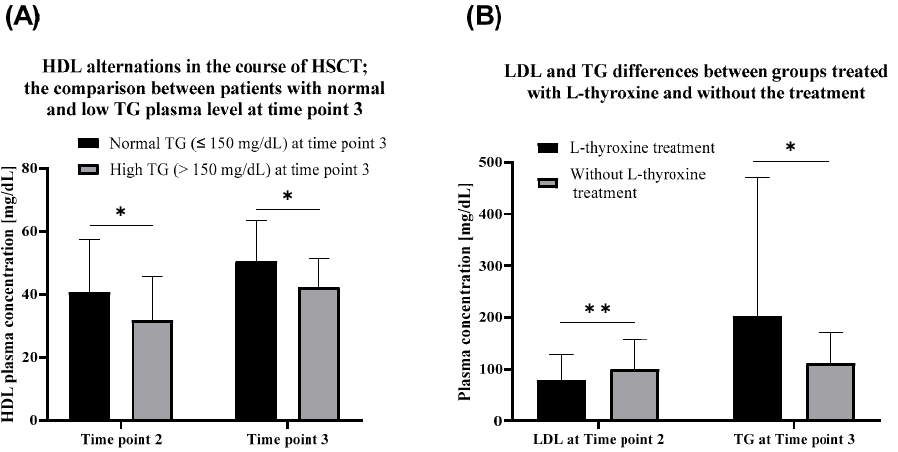
Figure 3. ( A ) HDL alternations in the course of HSCT; the comparison between patients with normal and low triglycerides plasma level (TG) at time point 3. ( B ) LDL (low-density lipoproteins) and triglycerides differences between groups treated with L-thyroxine and the without treatment. *, p < 0.01, (U-Mann-Whitney test). **, p < 0.05, (U-Mann-Whitney test). TG levels among patients with high and normal LDL before HSCT (at time point 1) did not differ after HSCT ( p = 0.904, time point 2) and in the recurring time ( p = 0.932, time point 3). LDL at time point 2 correlated (R = 0.52) with its current level and current cholesterol level (R = 0.17). Total serum cholesterol has not changed during the therapy ( p > 0.05). No correlation between BMI SDS and lipid levels was observed. 3.2. Thyroid Hormones and Thyroid Antibodies Analysis Fifty-eight patients were affected with thyroid disorders (Table 3), among which 41 were treated with L-thyroxine due to hypothyroidism. Patients treated with L-thyroxine exhibited lower LDL plasma concentration in comparison to the non-treated group. Conversely, TG is currently on a higher level in patients without thyroxine administration (Figure 3B). TSH levels correlated with total cholesterol at time point 2 (R = 0.22). No correlations between levels of TSH and TG were observed. Thyroid antibodies were evaluated after the HSCT (at time point 2) and served as reference data for further assumptions. The analysis revealed the presence of abnormally high TgAb and TPOAb in 23 and 45 patients, respectively. In some cases, thyroid antibodies did not reveal until a few years after the HSCT procedure. Patients with a normal level of TgAb exhibited increased HDL level at time point 2 (Figure 4A). Table 3. Frequency of developing thyroid function disorders after HSCT in the analyzed group. Number of Patients with the Disorder